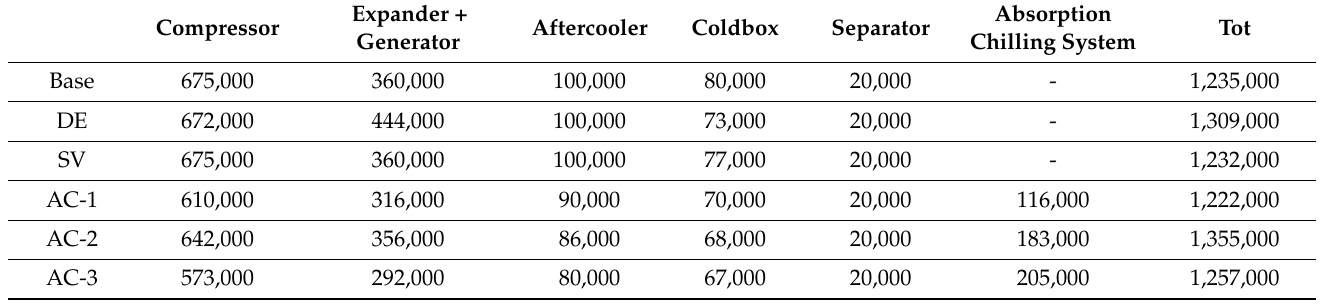
Table 3. All values are expressed in € .